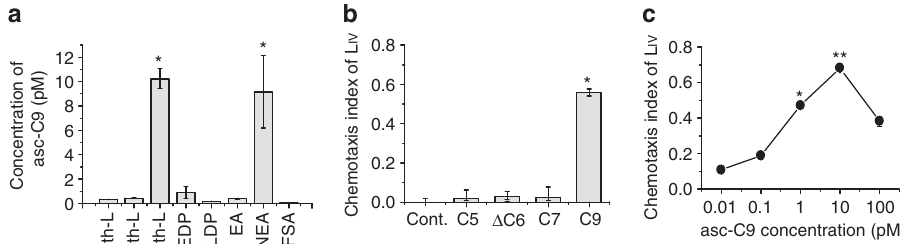
Figure 4 | Effect of the ascarosides produced by adult beetle on PWN behaviour. ( a ) The measurement of asc-C9 on the surface of the beetle from different developmental stages, including EDP, early development pupa; EA, emerging adult; FSA, fully sclerotized adult; L, larva; LDP, late development pupa; NEA, newly eclosed adult. Values are expressed as mean ± s.e.m. of five independent experiments. * P o 0.05 versus the L III larvae (Student’s t -test, unpaired and two-tailed). ( b ) Effects of different ascarosides at the same concentrations as produced by a chamber or one newly eclosed adult beetle on the chemotaxis index of PWN L IV larvae. Values are expressed as mean ± s.e.m. of 10 independent experiments. * P o 0.05 versus control (Student’s t -test, unpaired, two-tailed). ( c ) Dosage dependent effects of asc-C9 on the chemotaxis index of L IV . Values are expressed as mean ± s.e.m. of 10 independent experiments. * P o 0.05 versus 0.01pM and ** P o 0.01 versus 0.01pM (Student’s t -test, unpaired, B. mucronatus and M. alternatus in Asia, engage in ascaroside- non-native partners were introduced to one another. In the mediated interactions. Thus, the ascaroside-mediated future, it will also be interesting to investigate the effects of the interactions between the non-native partners PWN and ascarosides on B. mucronatus , which has been competitively M. alternatus would not necessarily have had to evolve de displaced by PWN in Asia 2,25 , as well as on PWN-associated fungi and bacteria. novo , but could have already been in place when the two